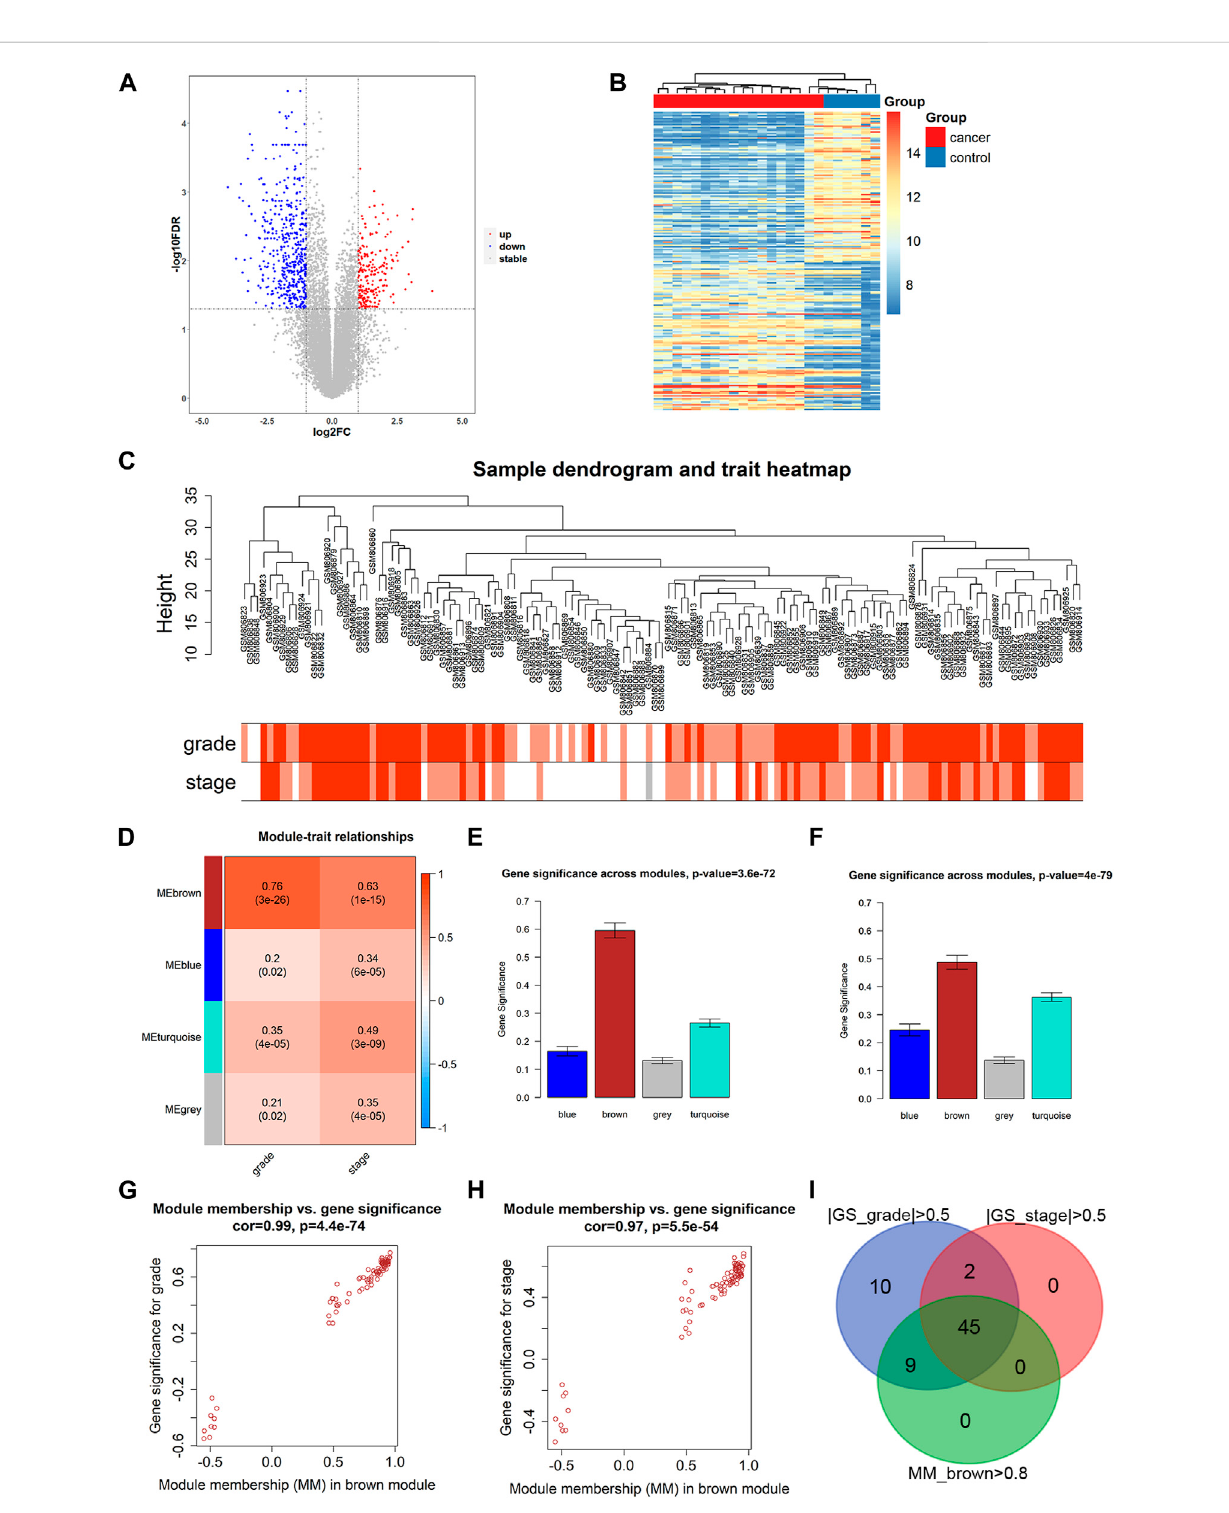
FIGURE 2 DEG analysis and WGCNA construction. (A) Volcano plot of GSE37815 DEGs. (B) Heatmap of GSE37815 DEGs. (C) GSE32548 clustering results and corresponding grade and stage information. (D) Correlation between ME of GSE32548 and clinical sample information. Distribution of GS and errors in themodules associated withthehistologic grade (E) and Tstage (F) ofbladdercancer. ScatterplotofGSandMM relatedto thehistologic grade (G) andT stage (H) of bladder cancer in brown module. (I) Venn diagram of bladder cancer grading-related GS, staging-related GS and brown module MM. ME, module eigengenes; GS, gene signi fi cance; MM, module